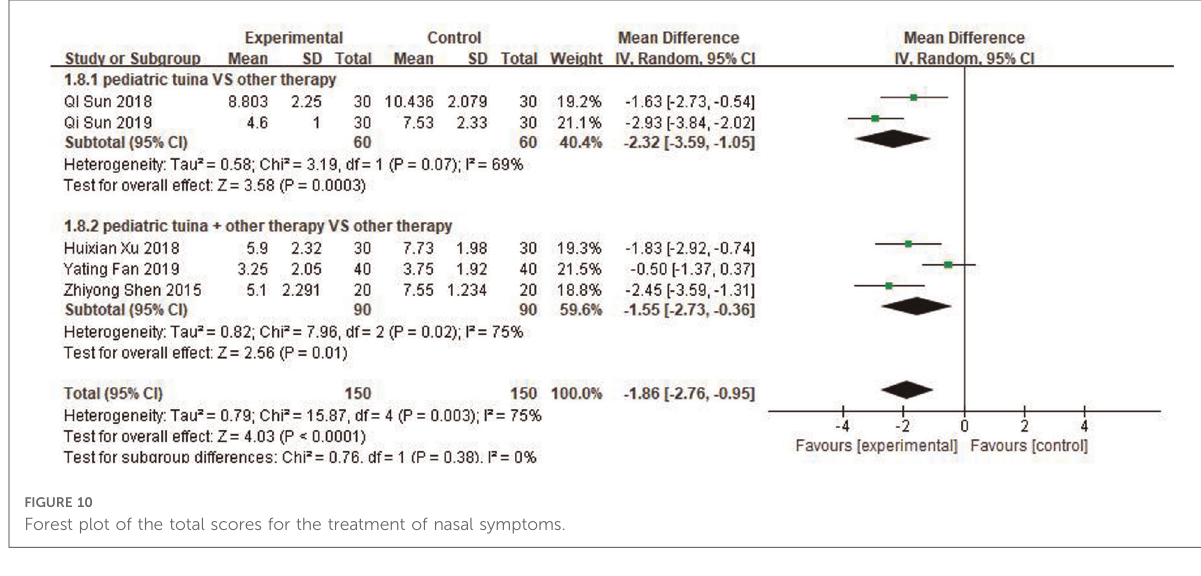
FIGURE 10 Forest plot of the total scores for the treatment of nasal symptoms.